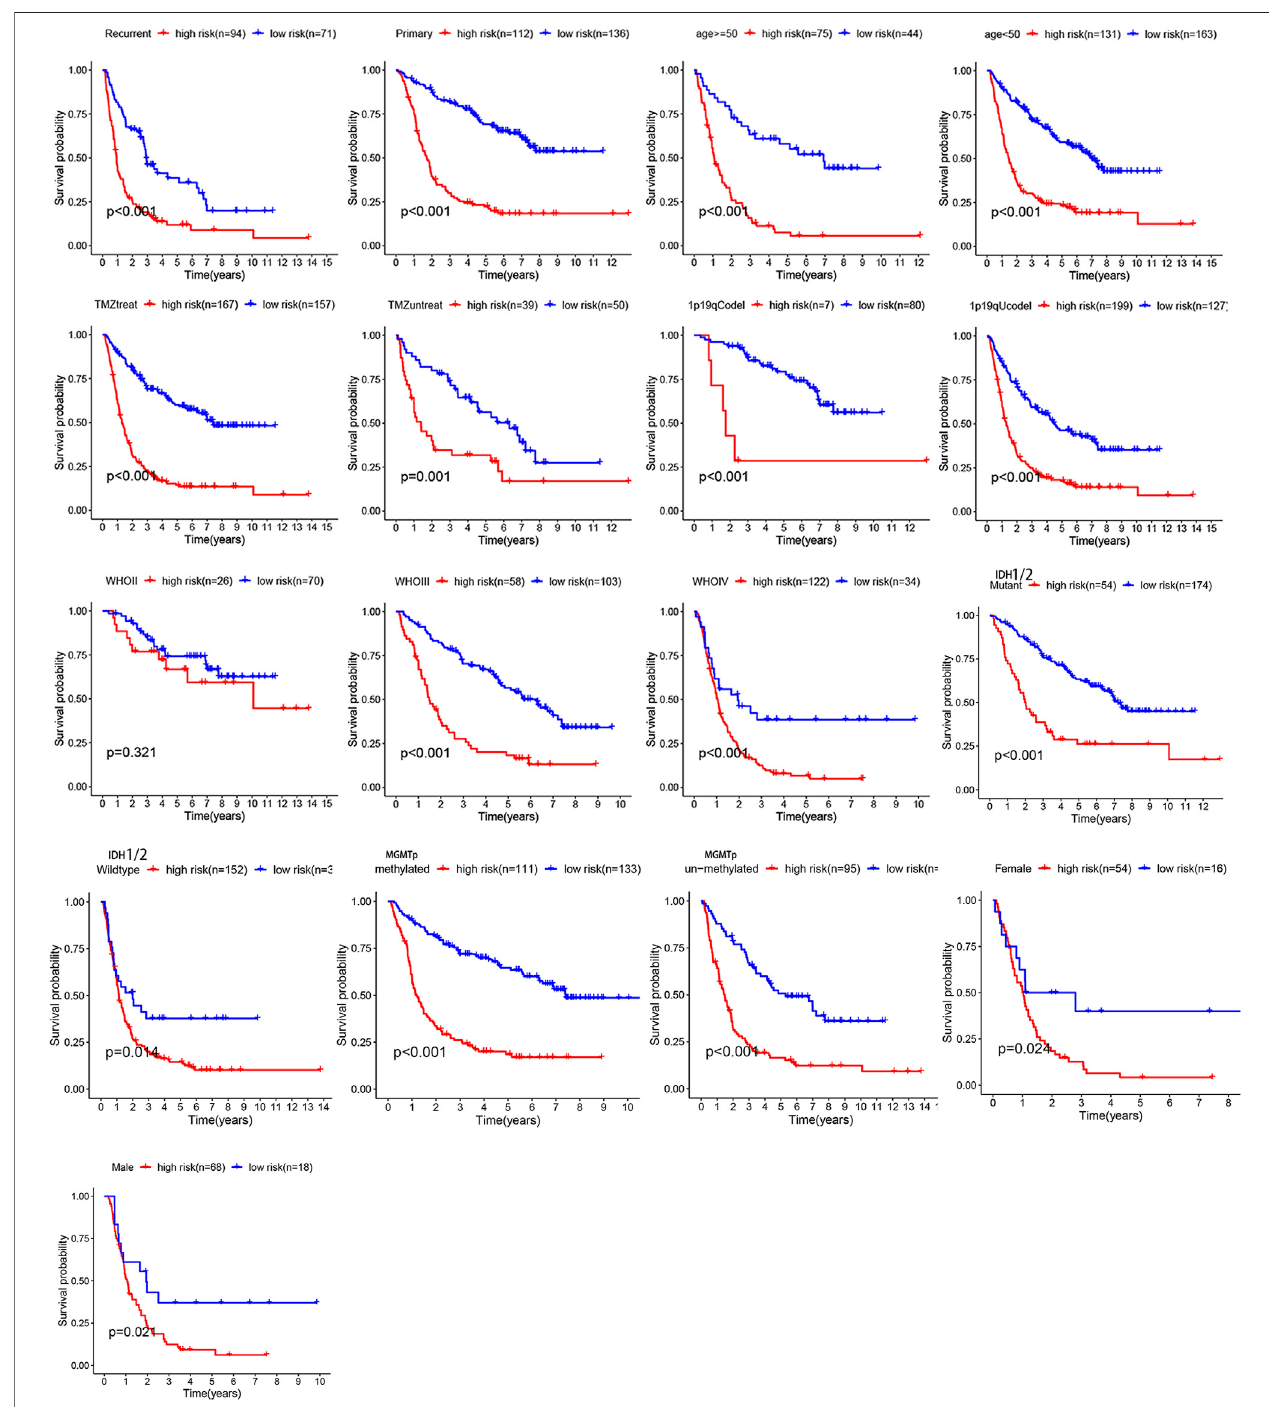
FIGURE 5 | The relationship between risk model and clinical characters. The model is not applicable to WHO grade II glioma ( p > 0.05).